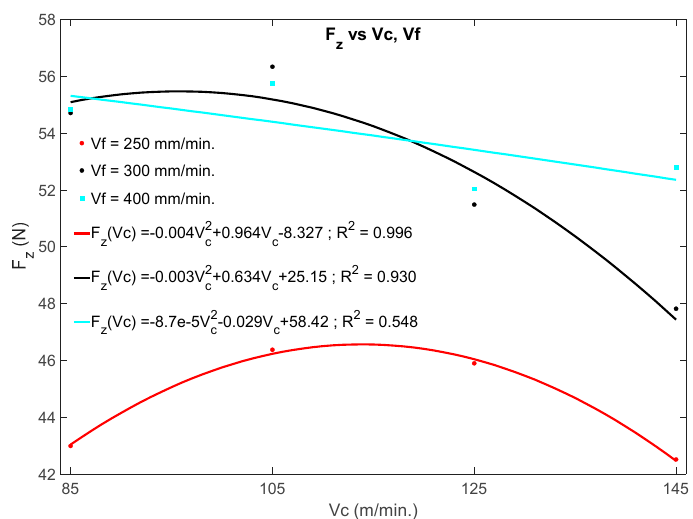
Figure 4. Effects of cutting speed and feed rate on the average thrust force ( Fz ). Figure 4. E ff ects of cutting speed and feed rate on the average thrust force ( Fz